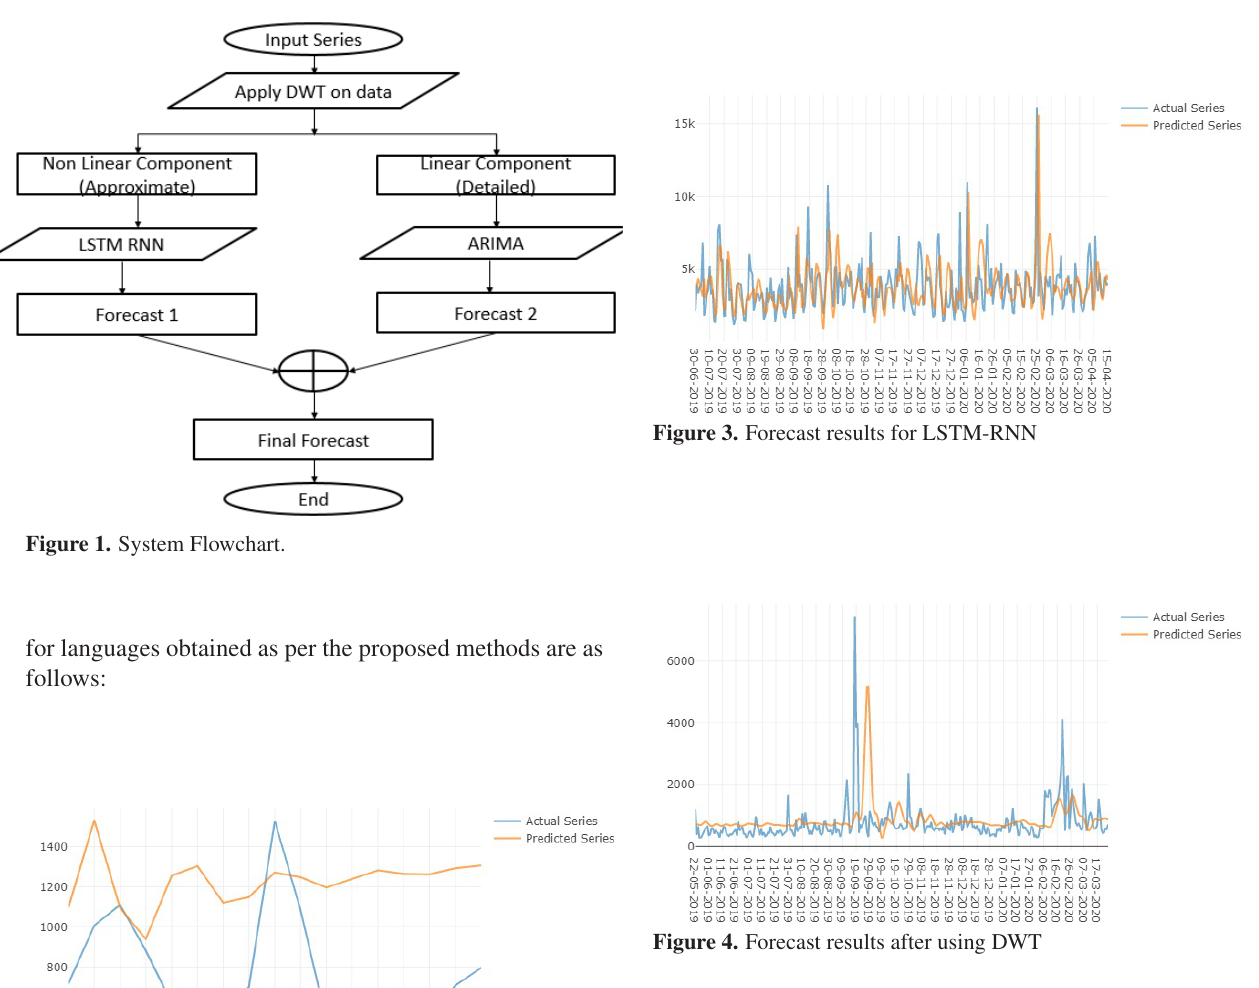
Figure 4. Forecast results after using